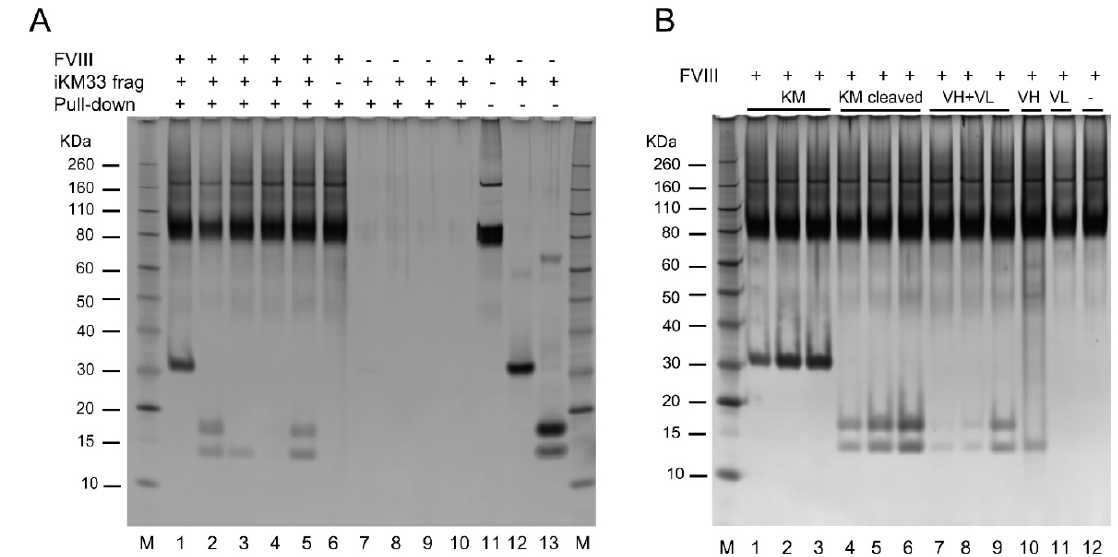
Figure 8. Testing interactions between FVIII and isolated iKM33 subunits. The interaction was evaluated by a pull-down assay using FVIII (BDD), iKM33-v1, and its thrombin-cleaved fragments (as shown on top) and FVIII-affinity sorbent; the resulting samples were analyzed by SDS-PAGE followed by gel silver staining. ( A ) Lanes 1–10 contain the samples, and lanes 11–13 contain control proteins. Specifically, lanes 1–6 contain FVIII (~2 µg), lanes 1–5 and 7–9 contain the scFv and its fragments (used at 3-fold molar excess over FVIII in pull-down assay) as follows: lanes 1 and 7 contain the scFv; lane 2 contains the thrombin-cleaved scFv, lanes 3 and 8 contain the V H , lanes 4 and 9 contain the V L , and lanes 5 and 10 contain a mixture of the V H and V L . ( B ) Analysis of dose-dependence of the scFv fragments used in a similar experiment: lanes 1–12 contain FVIII (~2 µg), lanes 1–9 contain the scFv, thrombin-cleaved scFv, and a mixture of V H and V L . In each group shown on top, the molar ratio of FVIII to the scFv fragments increases as 1:1, 1:2, and 1:5. Lane 10 contains the V H and lane 11 contains the V L ; both subunits were used at 5-fold molar excess over FVIII. In both panels, lane M contains a molecular weight marker. Each experiment was performed independently two times with similar results.